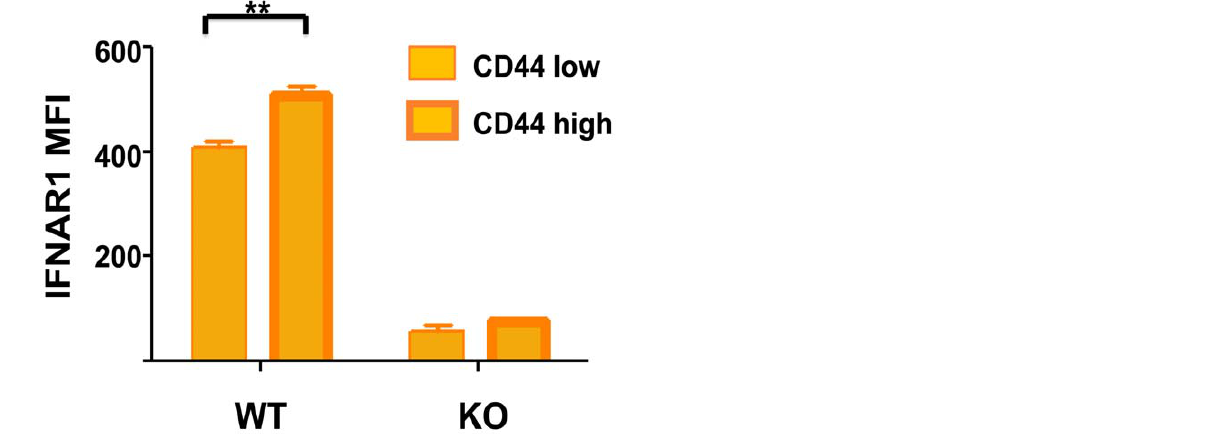
Figure 2. Higher type 1 IFN R (IFNAR1) expression on CD44 high memory phenotype CD8 T cells. Isolated spleen leukocytes from wild- type (WT) or IFNR knockout (KO) mice were stained with fluorescently labeled monoclonal antibodies (mAb) specific for CD8 (53-6.7; BD Pharmingen), CD44 (IM7; BD Pharmingen), and IFNAR-1 (MAR1-5A3; BioLegend). Stained samples were acquired using a BD Biosciences LSR II flow cytometer with FACS Diva software and analyzed with FlowJo software. The mean fluorescence intensity (MFI) for IFNAR1 is shown for CD44 low and CD44 high CD8 T cells, n =3/group. **, p , 0.005.